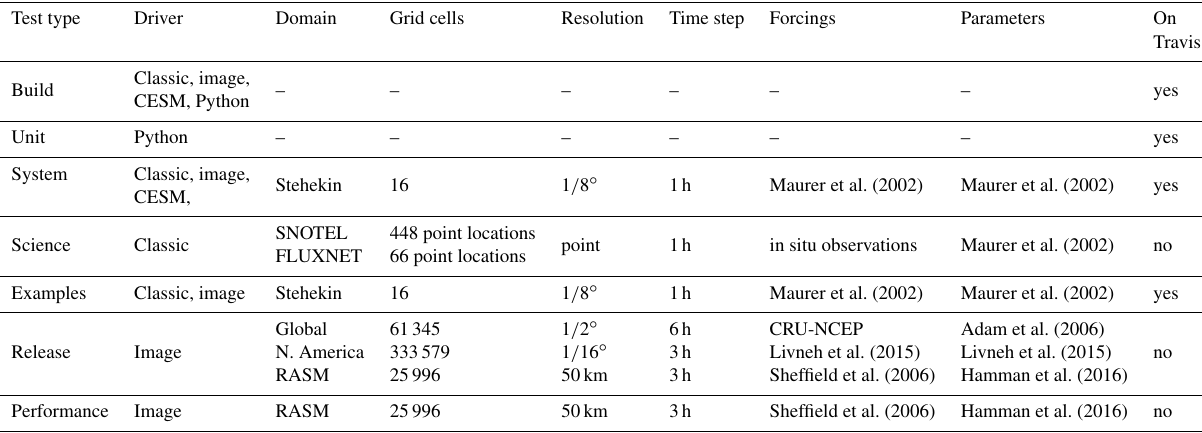
Table 2. Summary of tests and datasets.